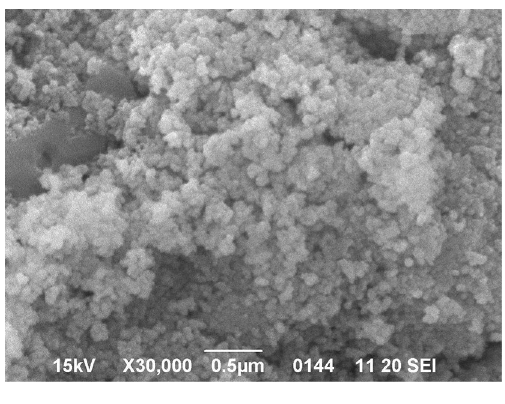
Fig. 8 SEM morphology of ZnO